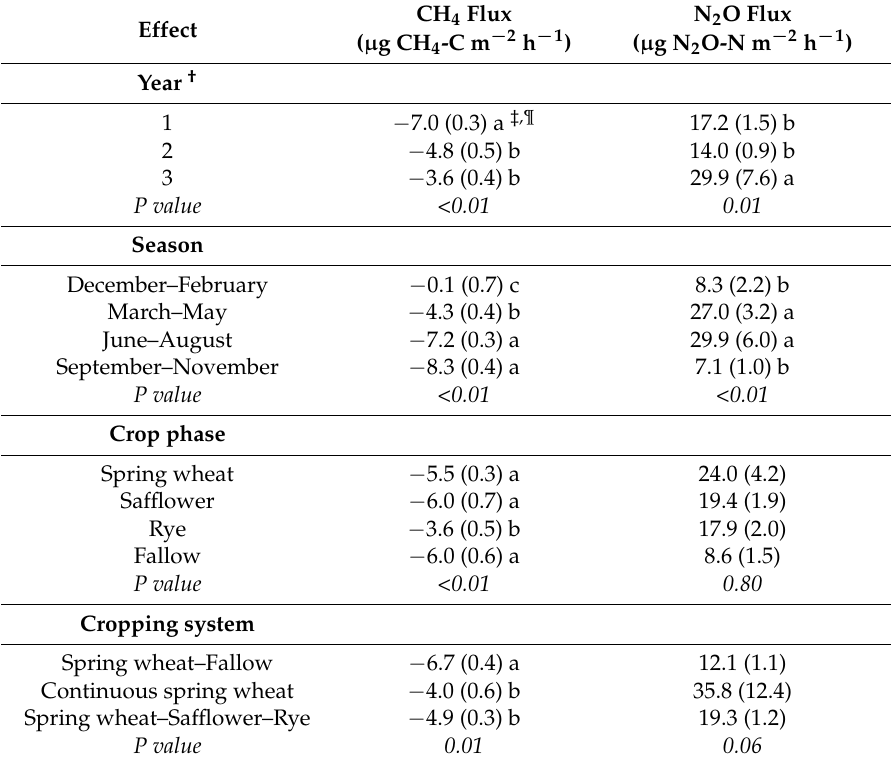
Table 4. Mean hourly flux for CH 4 and N 2 O partitioned by year, quarterly periods, crop phase and cropping systems. P values for comparisons within an effect are provided below the listed